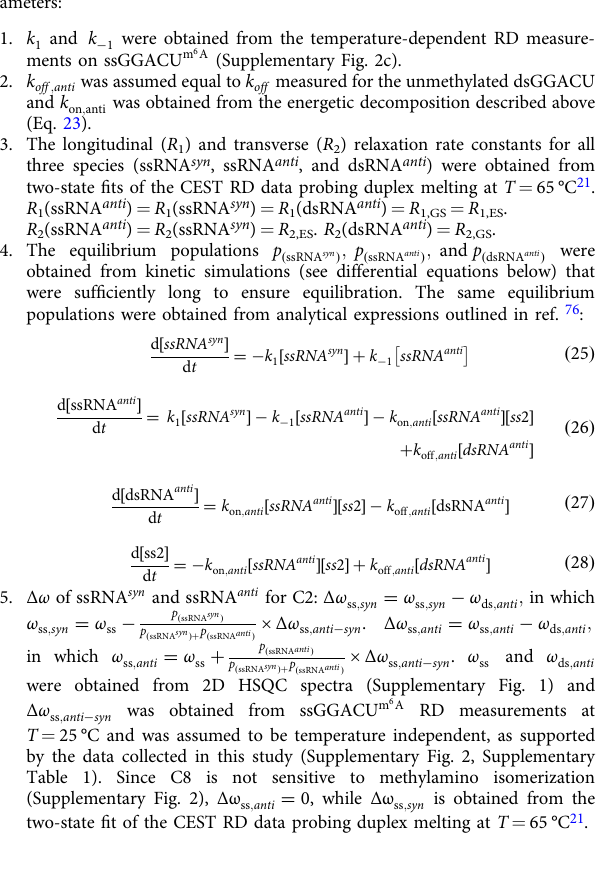
Three-state CS simulations and constrained fi ts for the dsA6DNA m 6 A RD data measured at T = 65 °C . These analyses used the following input exchange